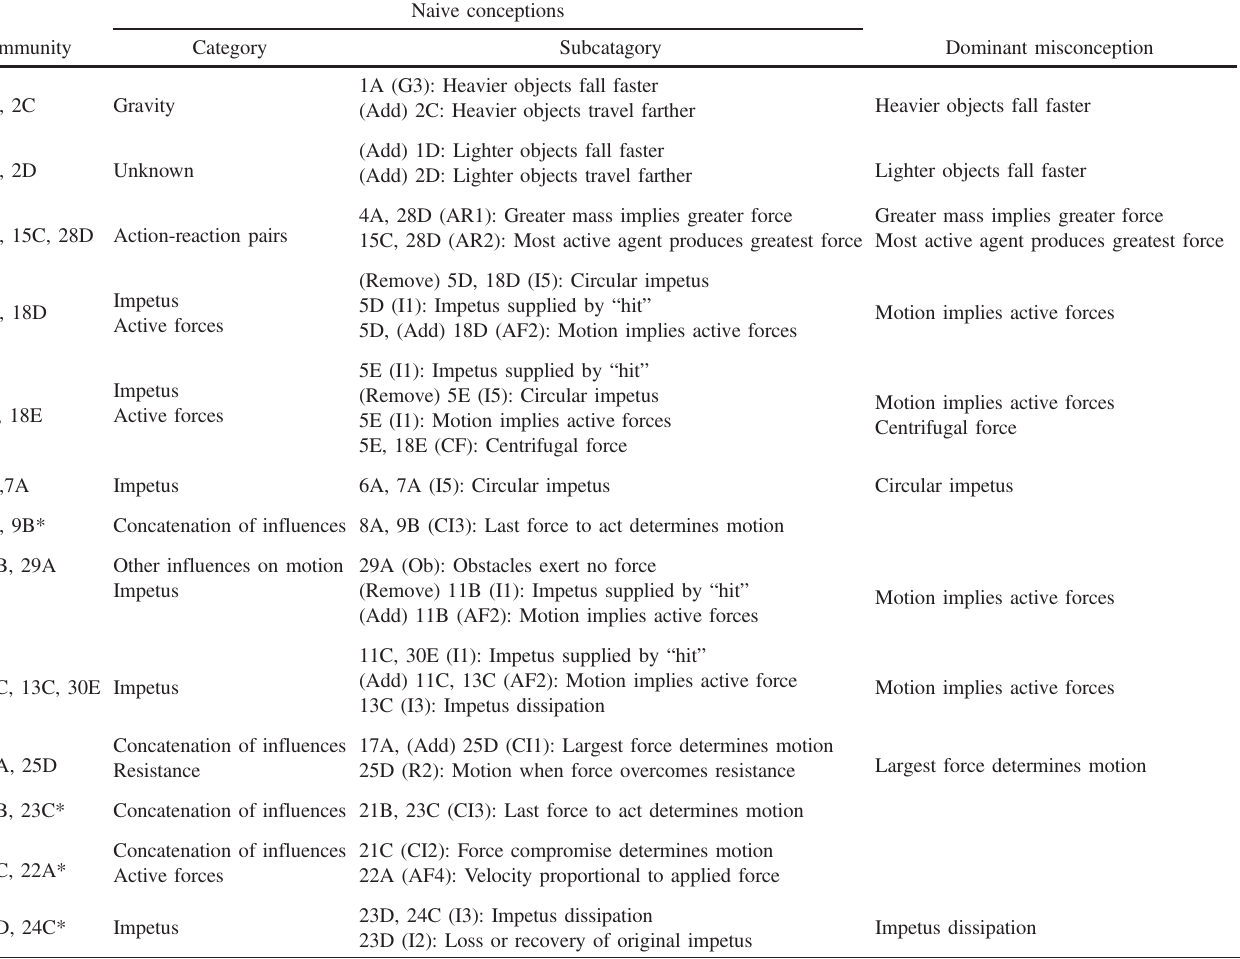
TABLE II. Misconceptions represented by incorrect answer communities. Communities marked with a (cid:4) result from blocked problems. Proposed additions are marked (Add). Proposed items to be removed are marked (Remove). If Add or Remove is placed before all items, it applies to all items. If Add or Remove is placed before only one of many items, it applies to that